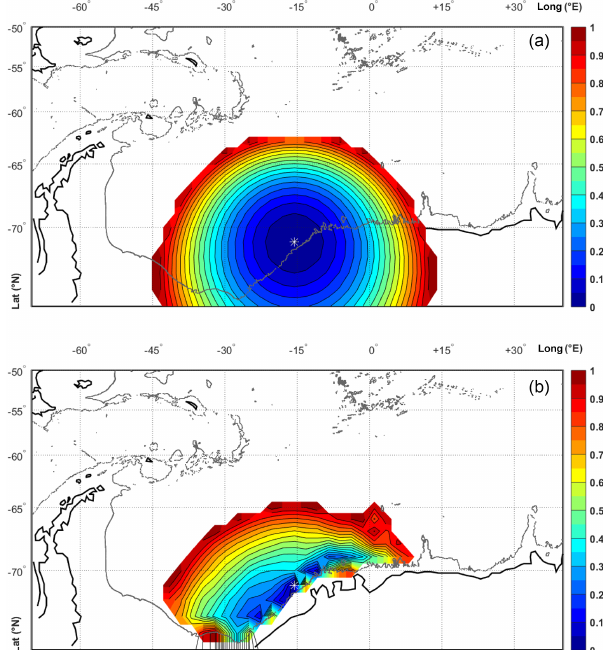
Figure 9. The e-folding decay scale for a grid point at ∼ 15 ◦ E, 71 ◦ S with (a) only a horizontal component (i.e. exp {−[ D 2 /L 2 ]} ) and (b) with the cross-isobathic separation factor as the second component of the decay scale (i.e. exp {−[ D 2 /L 2 + F 2 /(cid:56) 2 ]} ). See Sect. 3.2 for explanation. The grey contour shows the 2000m iso- bath.